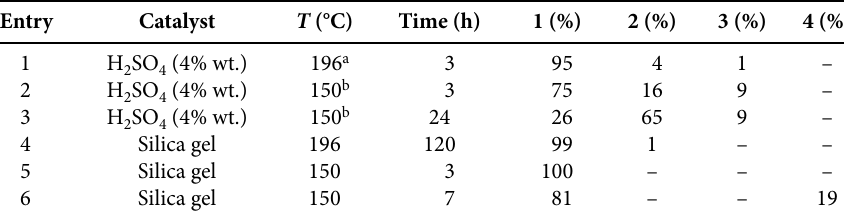
Table 1. Conversion of ethylene glycol ( 1 ) in homogenous acid